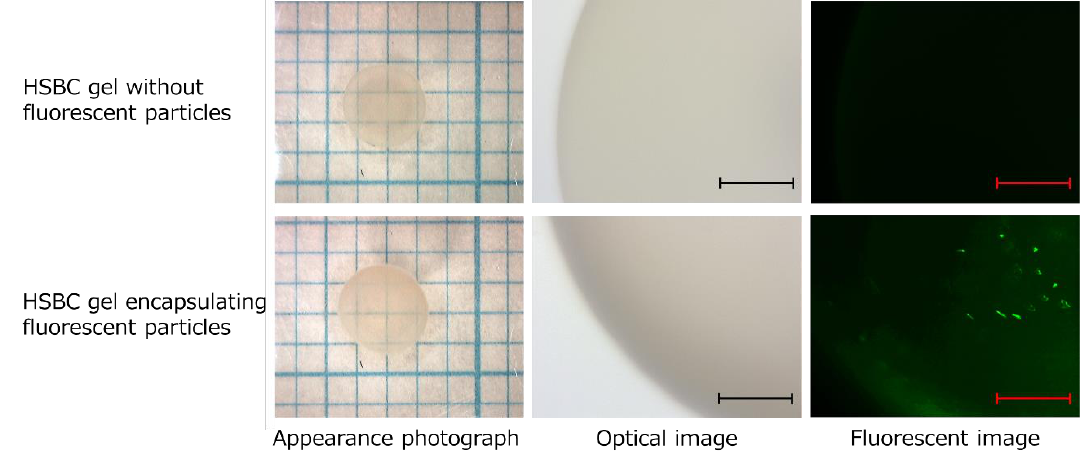
Figure9. PhotographsofHSBCgelwithoutfluorescentparticlesandHSBCgelencapsulatingfluorescent Figure 9. Photographs of HSBC gel without fluorescent particles and HSBC gel encapsulating particles. Scale bar: 300 µ m. fluorescent particles. Scale bar: 300 µm.